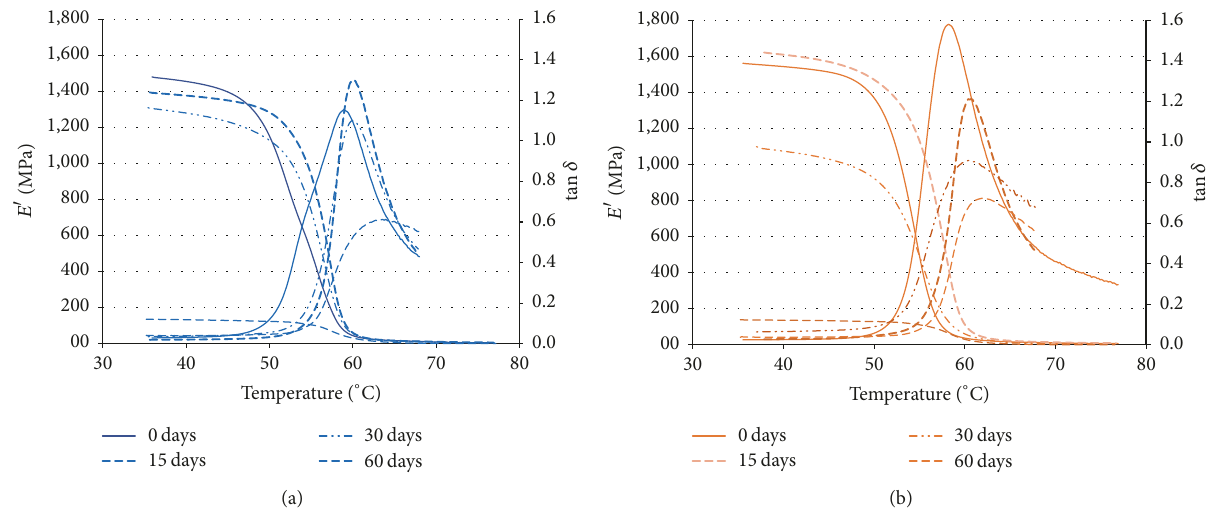
Figure 2: Representative curves of storage modulus (𝐸 󸀠 ) and tan 𝛿(𝐸 󸀠󸀠 /𝐸 󸀠 ) as a function of the temperature obtained by DMA of the different degradation points (e.g., 0, 15, 30, 60, and 120 days) for PLGA low T (a) and PLGA high T (b).